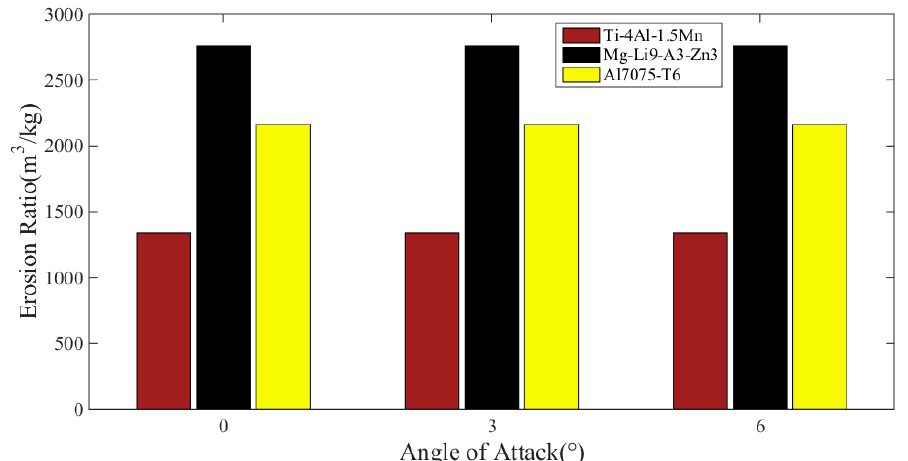
Figure 10. Erosion ratios of three materials at different angles of attack.